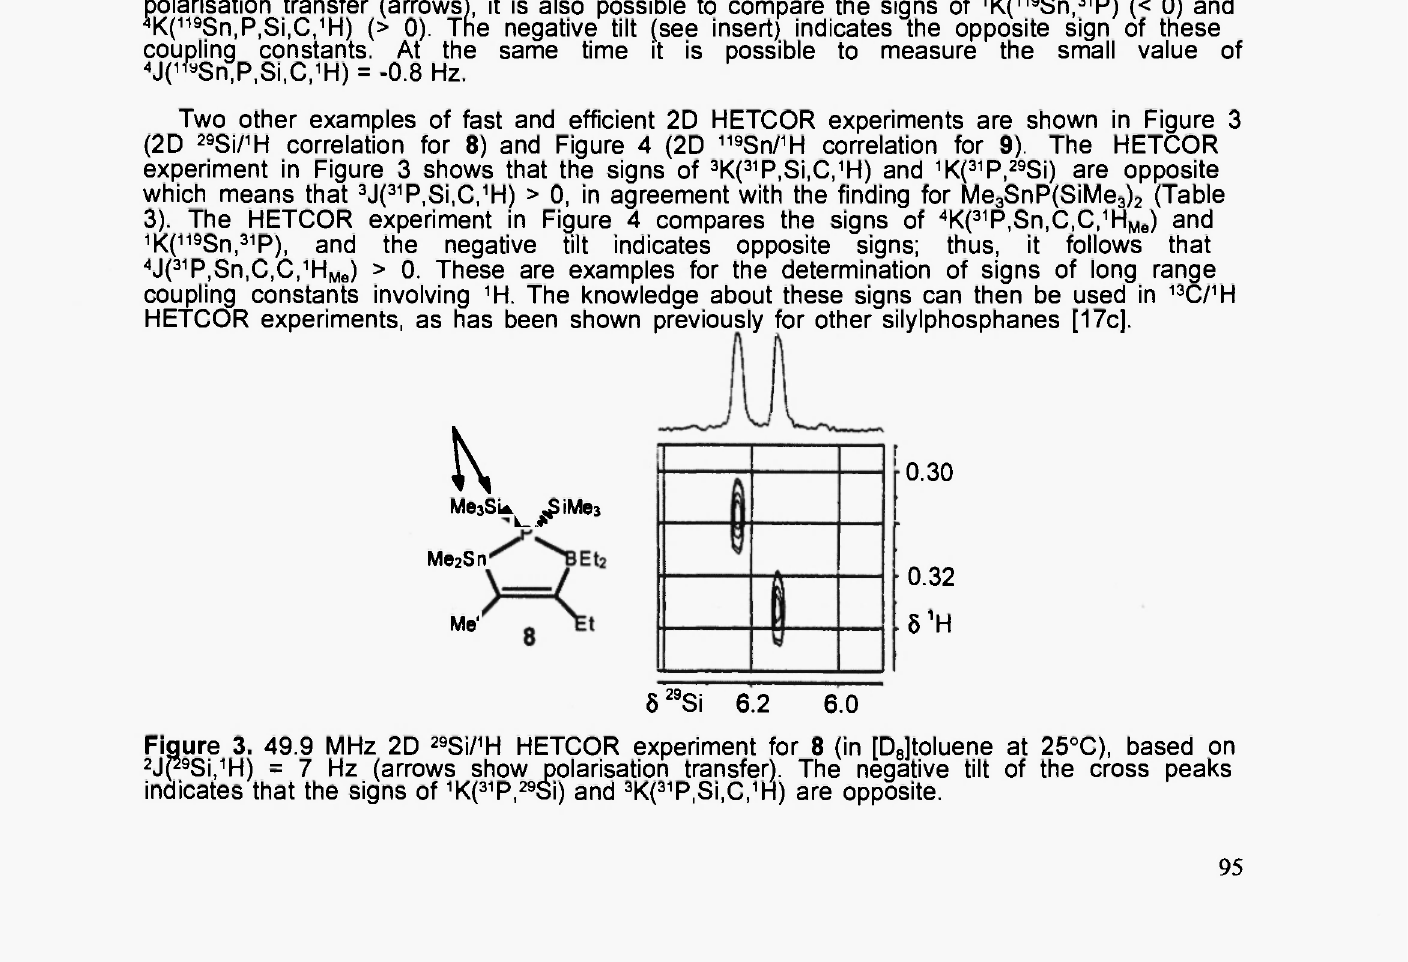
Figure 3. 49.9 MHz 2D 29 Si/ 1 H HETCOR experiment for 8 (in [D 8 ]toluene at 25°C), based on 2 J( 29 Si, 1 H) = 7 Hz (arrows show polarisation transfer). The negative tilt of the cross peaks indicates that the signs of 1 K( 31 P, 29 Si) and 3 K( 31 P,Si,C, 1 H) are